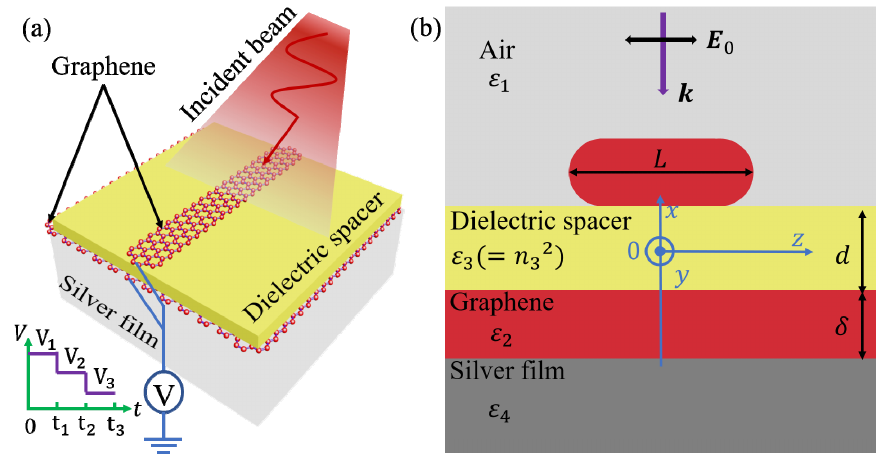
Figure 1. ( a ) The schematic diagram and ( b ) cross section of the coupled graphene structure (CGS). The adopted Cartesian coordinate system is shown in ( b ).